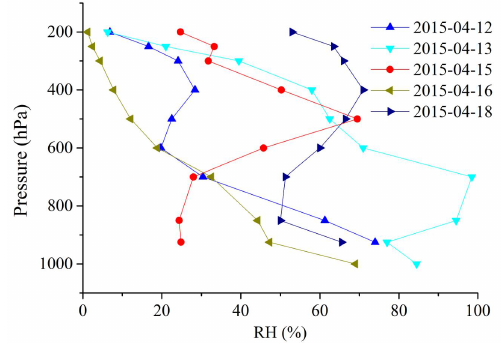
Figure 12. Relative humidity during dusty and non-dusty days. The red line represents profile during the dusty day.